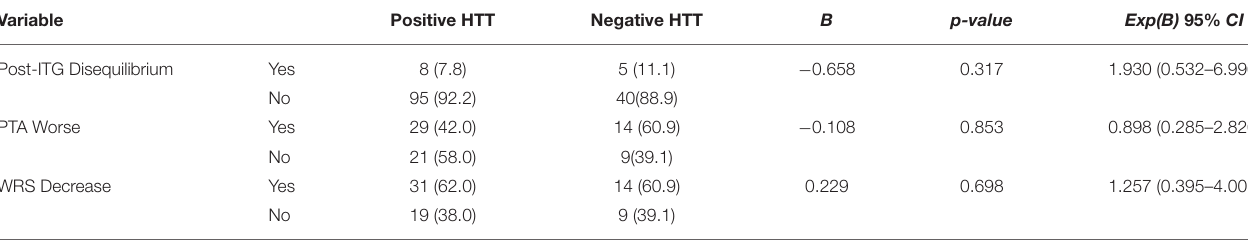
TABLE 4 | Comparison of side effects between the positive and negative groups of the post-ITG treatment HTT (%)*.